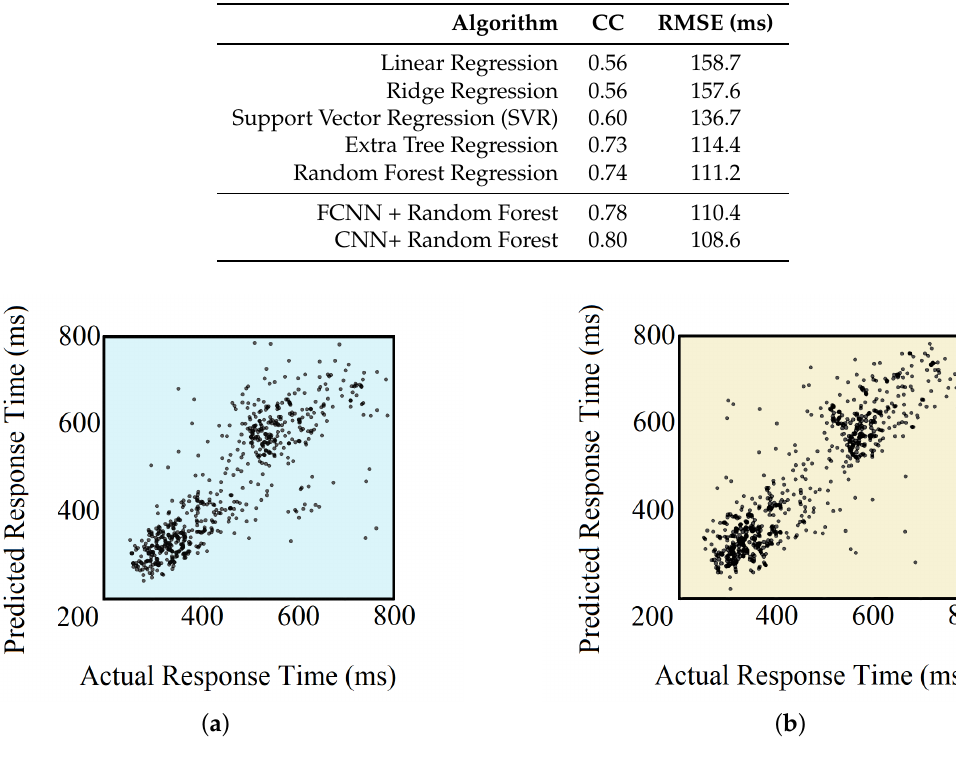
Figure 12. Actual vs. predicted RTs using ( a ) FCNN + Random Forest-based model and ( b ) CNN + Random Forest-based model.